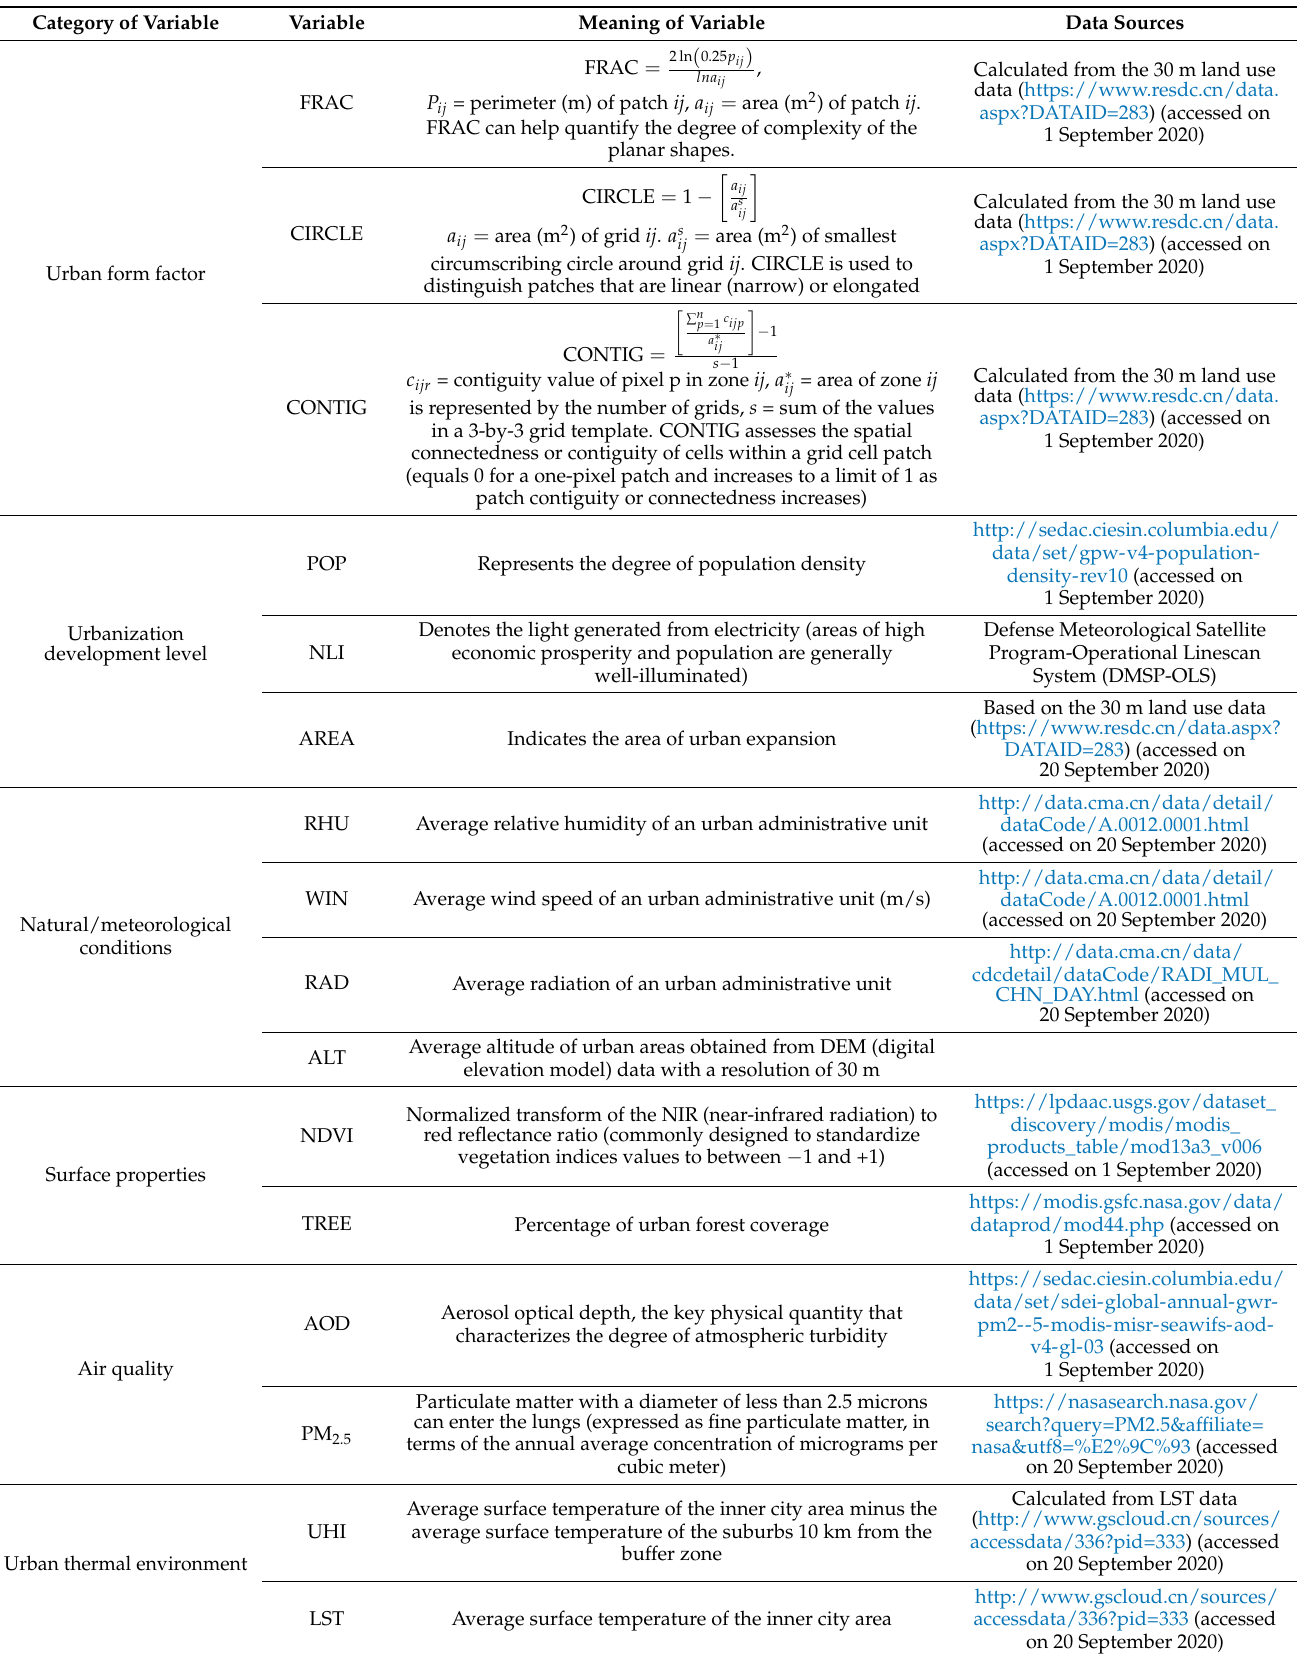
Table 1. Influencing factors on precipitation used in this